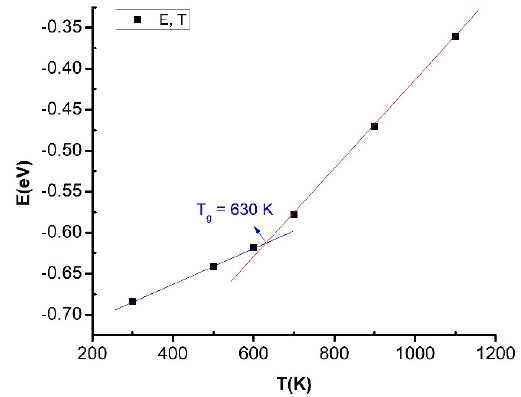
Figure 5. The shape ( a ), RDF ( b ), and CN ( c ) of the ANPs of Ni 5324 with respect to T. To determine the T g value of the ANPs of Ni 5324 , the dependence of the E on the T was examined (Figure 6).